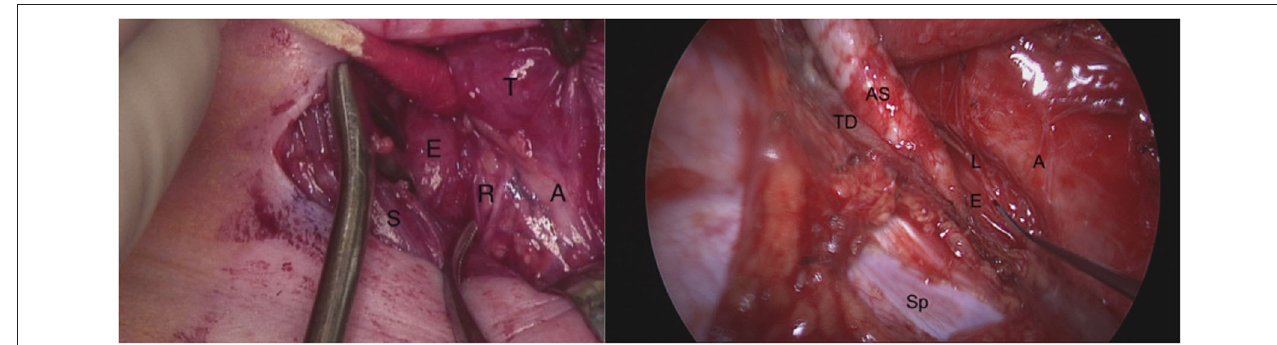
FIGURE 1 | On the left: Right neck dissection during tracheoesophageal fistula repair demonstrating the right recurrent laryngeal nerve in the tracheoesophageal groove branching before it enters the larynx. T, thyroid gland; A, airway (trachea); S, sternocleidomastoid muscle; E, esophagus; R, two branches of right recurrent laryngeal nerve. On the right: The left recurrent laryngeal nerve seen from posterolateral direction during a right thoracotomy (right non-recurrent laryngeal nerve not shown). The probe is pointing to the left recurrent laryngeal nerve as it lies on the thoracic esophagus. AS, aberrant right subclavian artery; TD, thoracic duct; E, esophagus; A, airway (trachea and bronchi); Sp, spine; L, left recurrent laryngeal